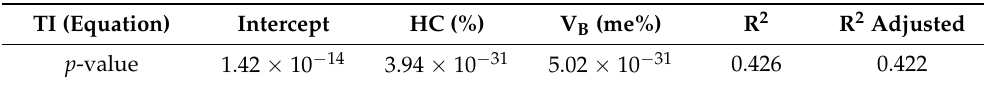
Table 3. Parameters in the potential trophicity